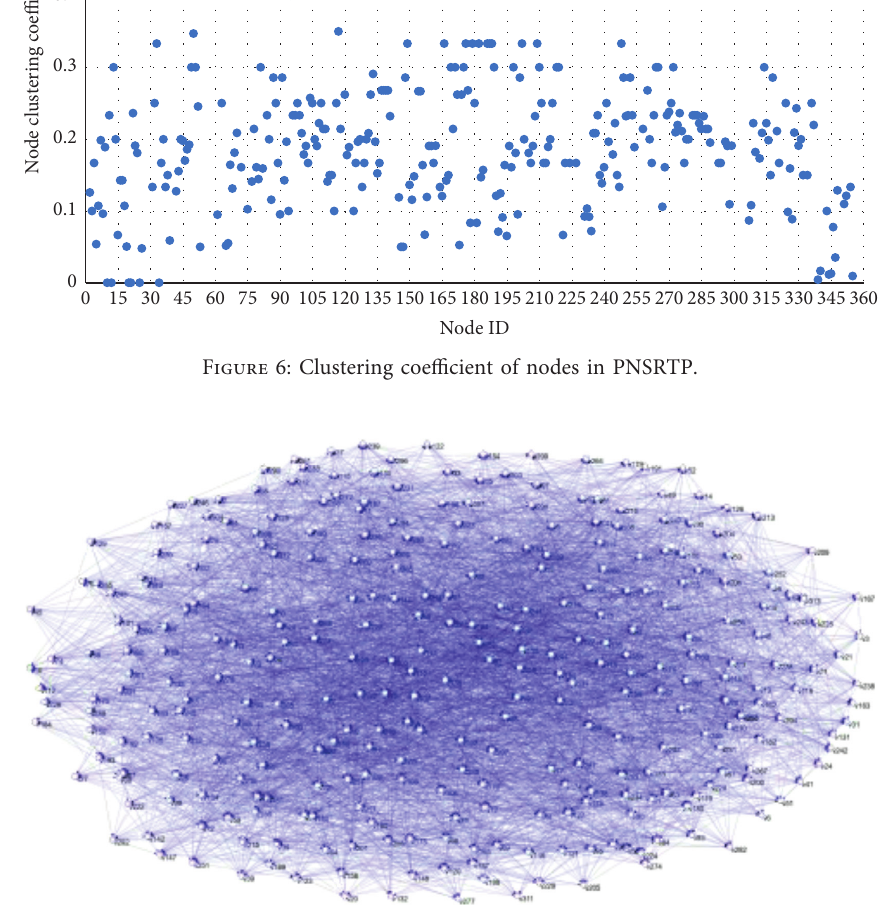
Figure 7: Equal-sized seepage risk random network.